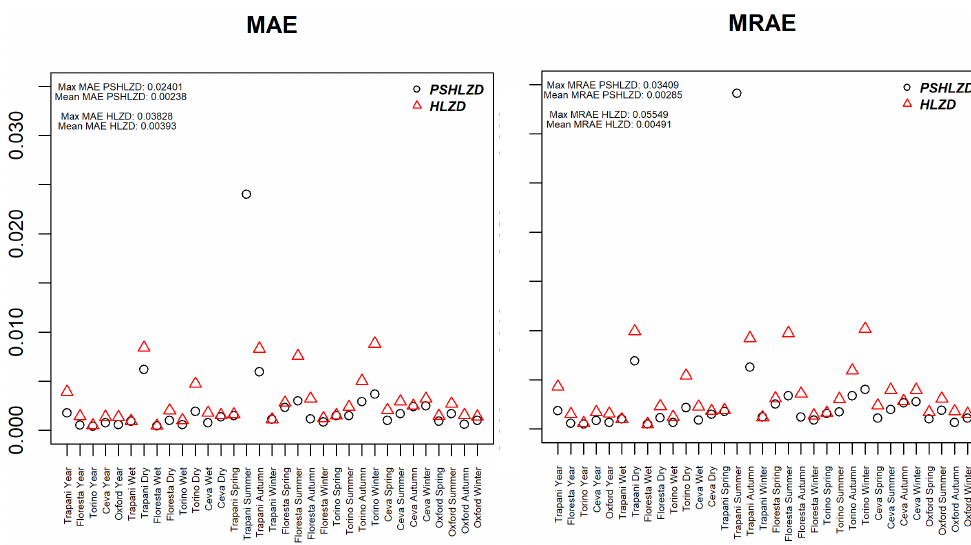
Figure 3. Dot plots of MAE and MRAE taking as reference the cdf of the PSHLZD (black circle) and of the HLZD (red triangle) for all the IT samples. The maximum MAE as well as the mean MAE are given in the top left for both the fitting